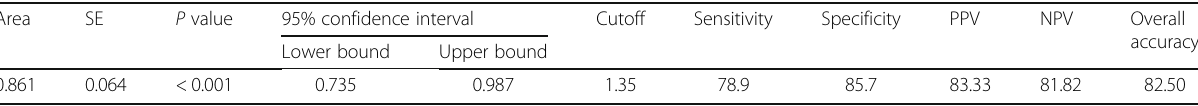
Table 5 Roc curve analysis revealed that ADC value was a significant discriminant factor in predicting non-viable from viable treat lesions groups ( p value < 0.001) with AUC 0.861 and 95% confidence interval (0.735 – 0.987)